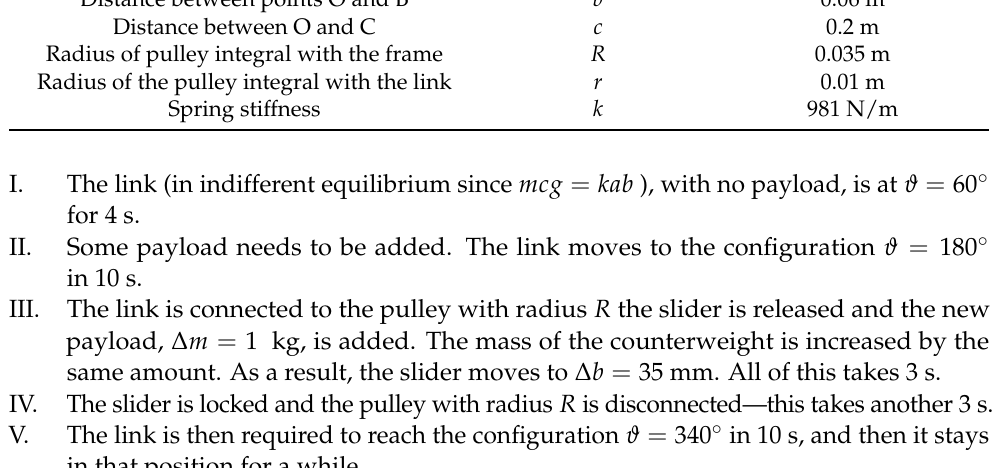
Table 1. Parameters of the simulated system. Quantity Symbol Value and Unit m 3